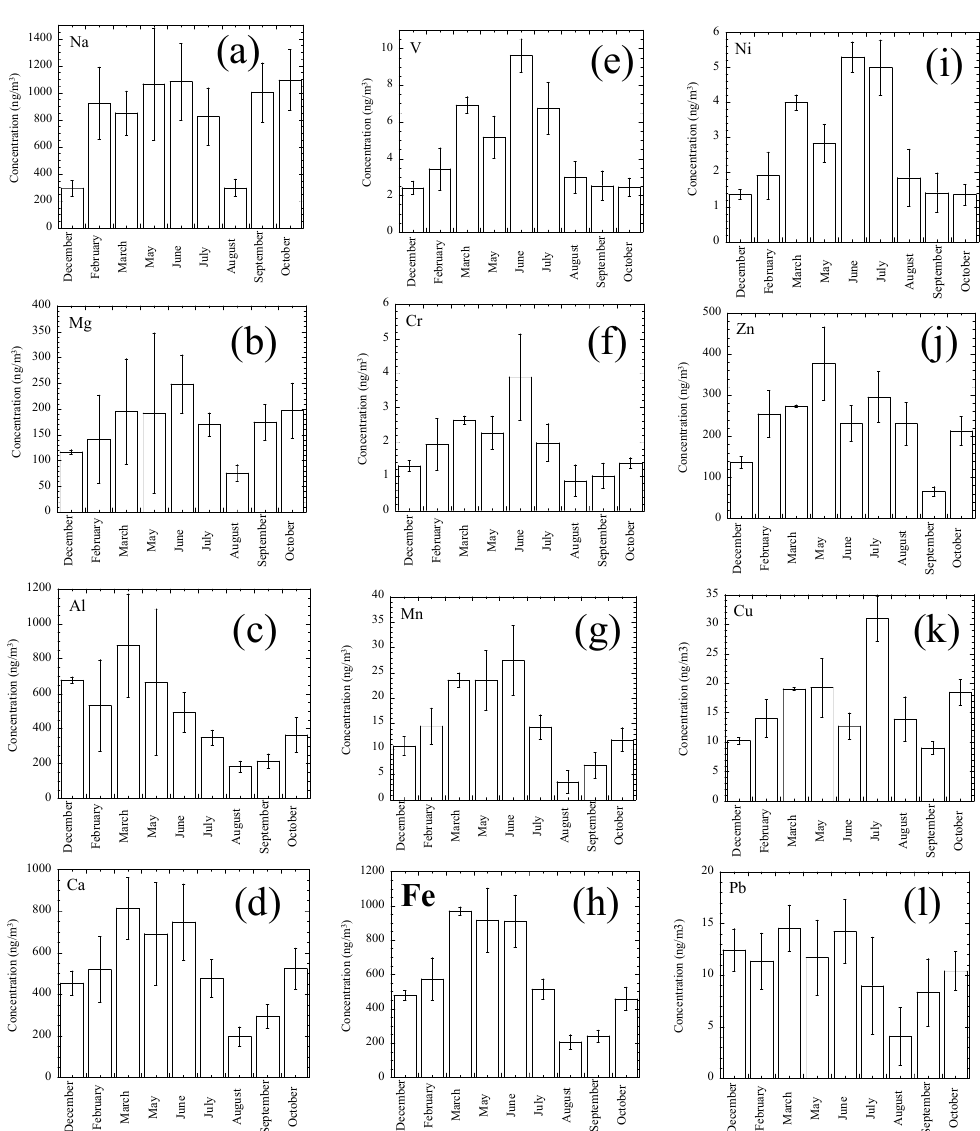
Fig. 3. Concentration of various metal ions in aerosol collected at Tsukuba. (a) sodium (Na), (b) magnesium (Mg), (c) aluminum (Al), (d) calcium (Ca), (e) vanadium (V), (f) chromium (Cr), (g) manganese (Mg), (h) iron (Fe), (i) nickel (Ni), (j) zinc (Zn), (k) copper (Cu), and (l) lead (Pb). Error bars are standard deviations obtained by three independent